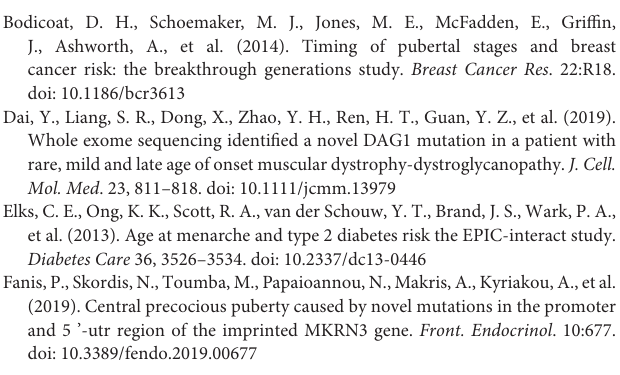
FIGURE 3 | presented as mean ± SD, one-way ANOVA was used with the Bonferroni post-hoc test over three independent experiments. (F) Mutation of MKRN3 attenuated its inhibition on GnRH1 levels in GT1-7 cells. GT1-7 cells were transfected with empty vector, wild-type MKRN3, or the G93S mutant. A total of 48h later, the supernatant was collected and detected by ELISA. Data are presented as mean ± SD, one-way ANOVA was used with the Bonferroni post-hoc test over three independent experiments. * P < 0.05, significant difference; ** P < 0.01, very significant difference, over three independent